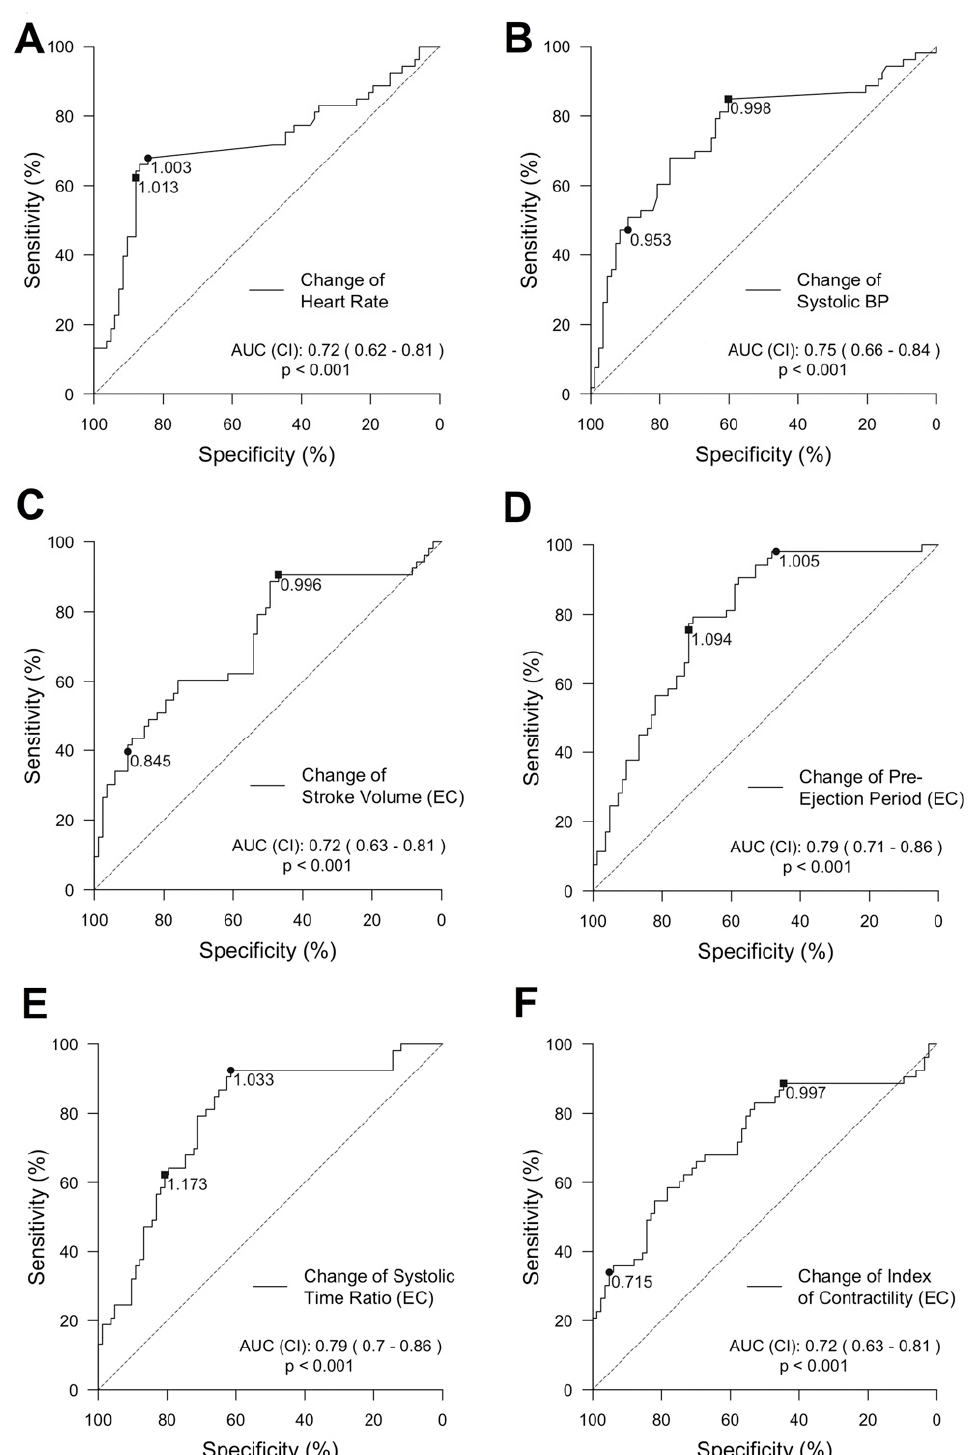
Figure 5. ROC curves and grey zones of the selected features: ROC curves in predicting a decrease in SV-TTE for the selected hemodynamic values (one per panel). The subfigures ( A – F ) describe the change of the vital signs Heart Rate and Systolic BP ( A , B ) and selected parameter determined by EC ( C – F ). ROC curves are displayed in the usual fashion. The area under the curve (ROC-AUC) and its confidence intervals (CI) due to bootstrapping can be found at the bottom right of each plot. The cut-off values of the diagnostic grey zone are shown on the ROC curve. (EC): indicates values determined by electrical cardiometry; BP: blood